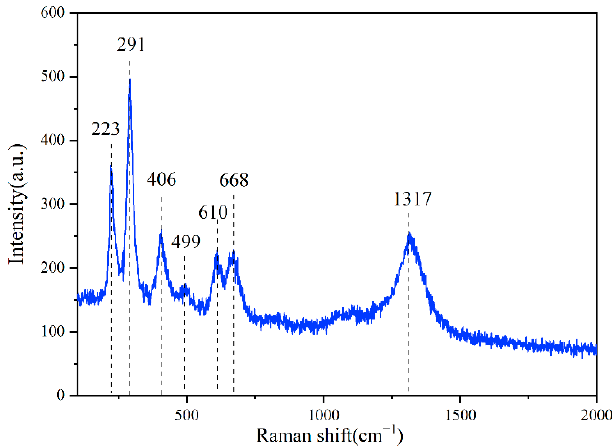
Figure 6. Wave-absorbing susceptor for AC microwave preparation samples.